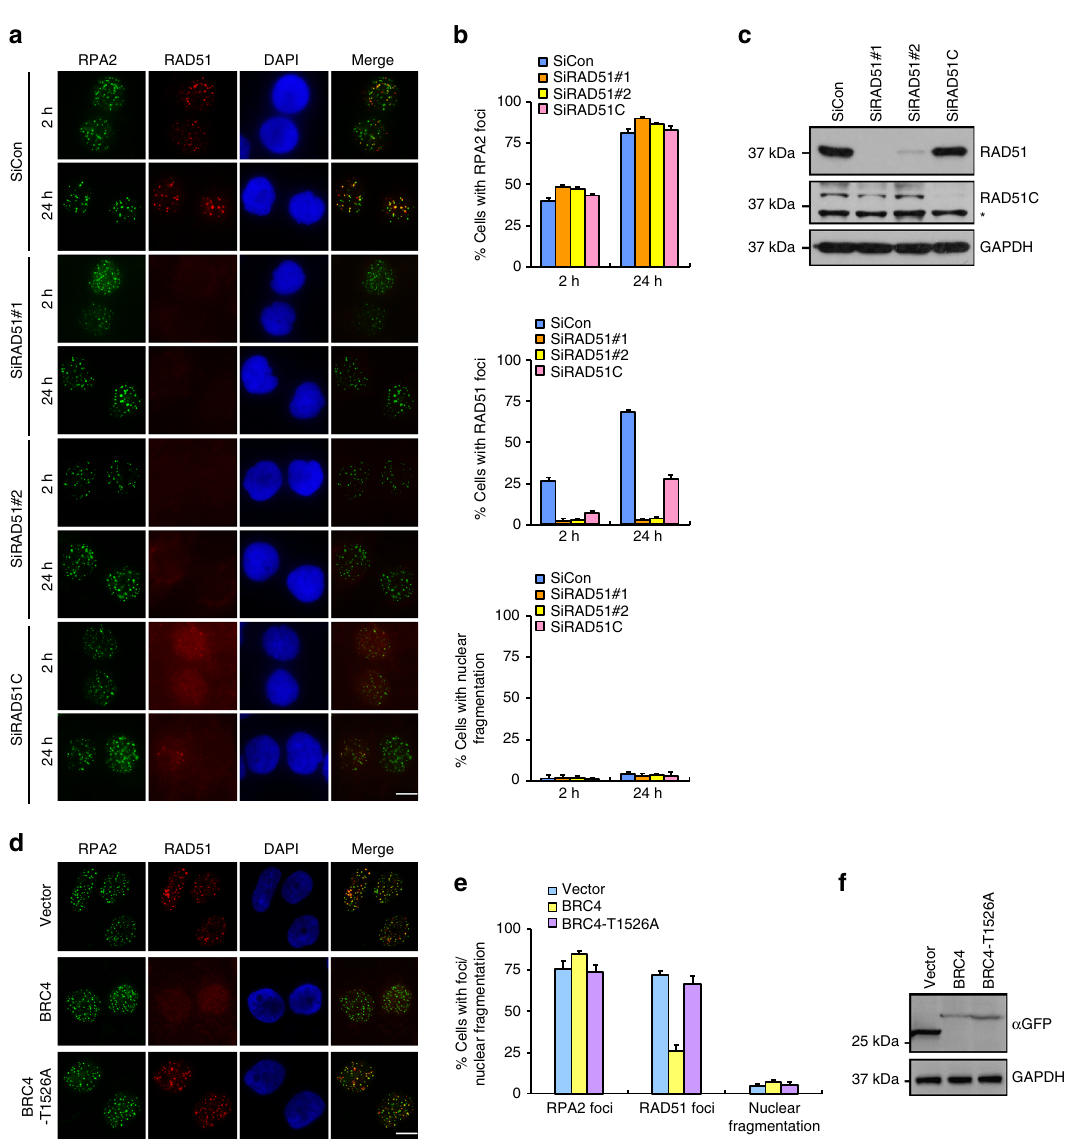
Fig. 1d – f, RPA2 foci resolved more readily in VC-8 cells than in VC-8 cells reconstituted with BRCA2.